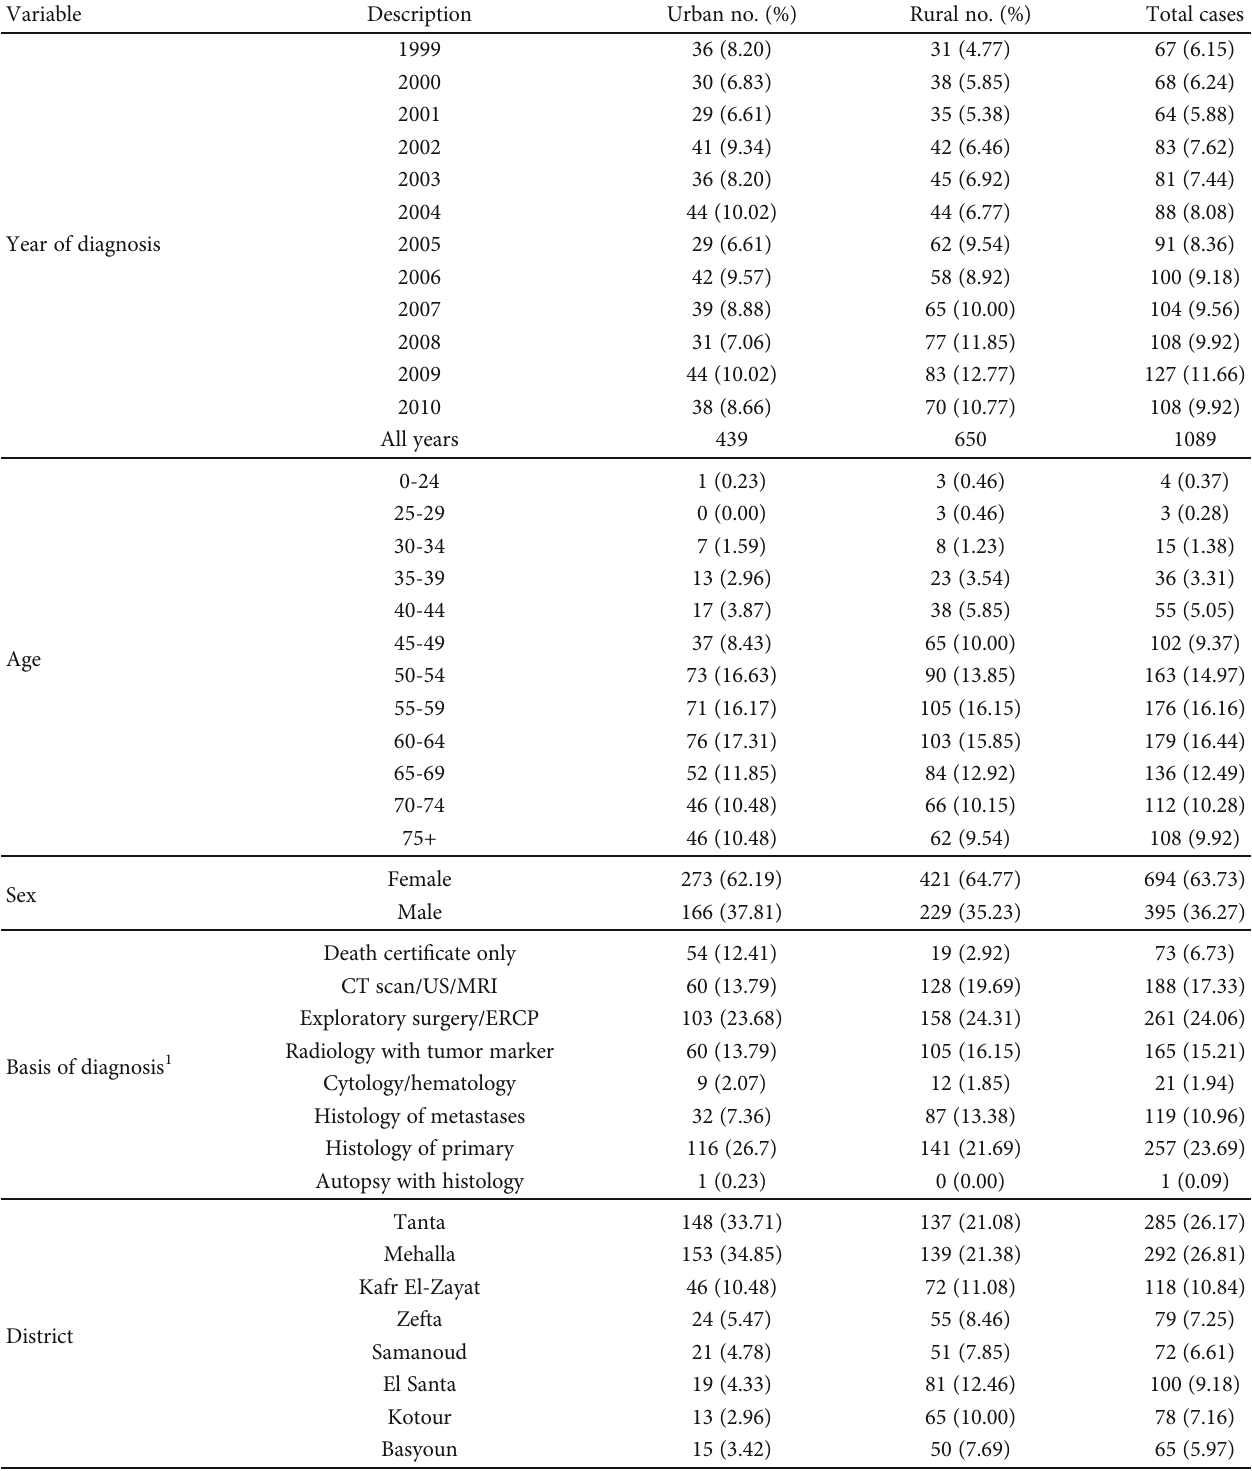
Table 1: Clinical and demographic characteristics of 1,089 pancreatic cancer cases in Gharbiah during the period of 1999-2010 by urban and rural places of